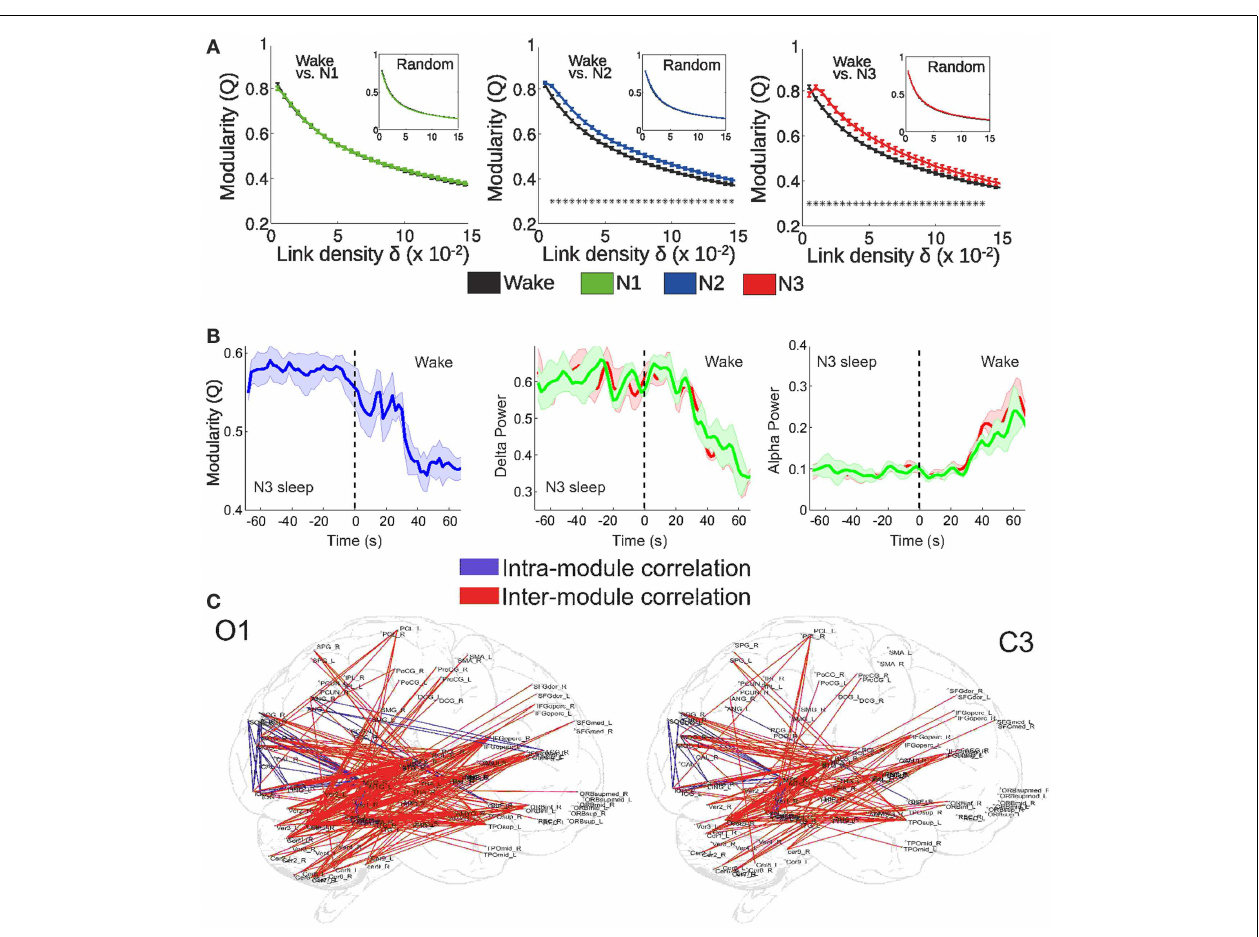
Two different EEG channels were used to extract EEG alpha and delta power: occipital O1 (red) and central C3 (green). (C) Anatomical overlay of links representing negative correlations between functional connectivity fluctuations of the connected regions and spontaneous fluctuations of EEG delta power (thresholded at p < 0.05, Bonferroni corrected). Adapted from Tagliazucchi et al. (2013). Figure reproduced with permission from